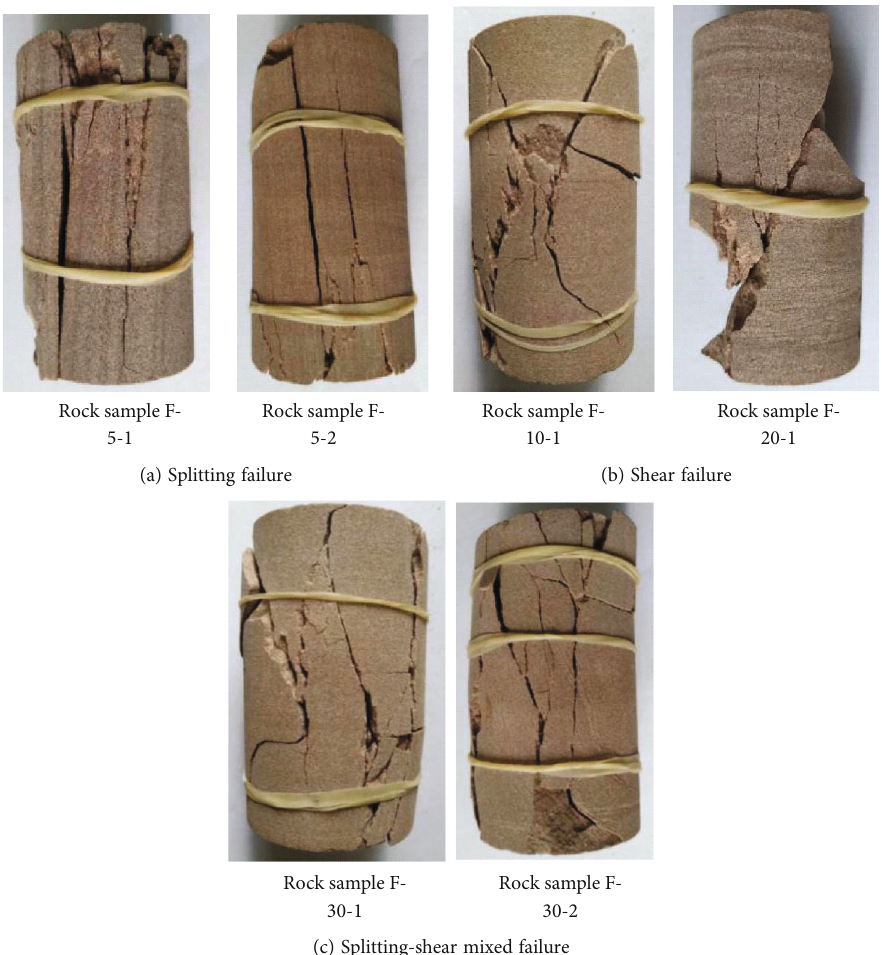
Figure 6: Uniaxial compression failure modes of freeze-thaw cycled